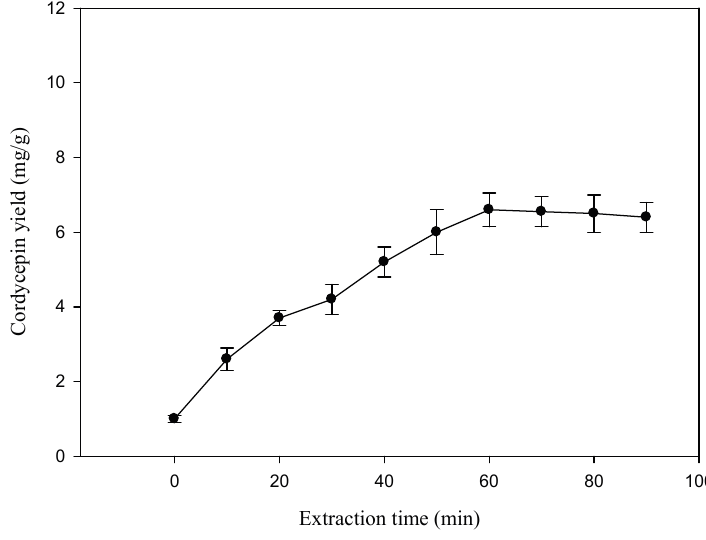
Figure 2. Effect of extraction time on the extraction yield of cordycepin from C. militaris . Ethanol concentration: 50%; extraction temperature: 60 °C; ratio of liquid to solid: 20 mL/g; extraction frequency: 40 kHz.